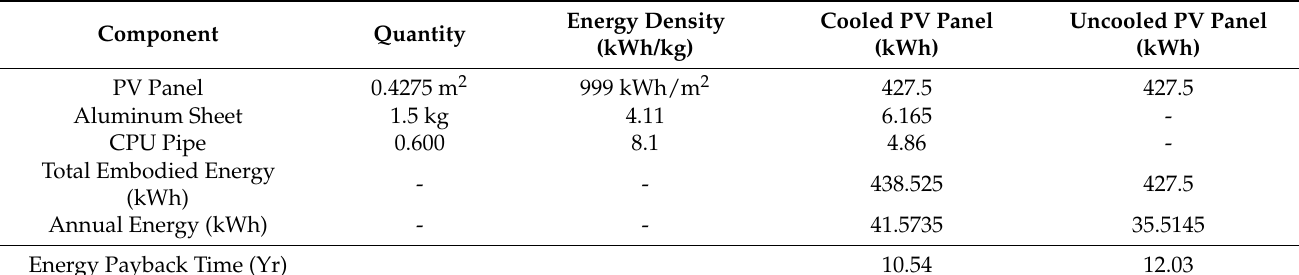
Table 6. Embodied energy for PV